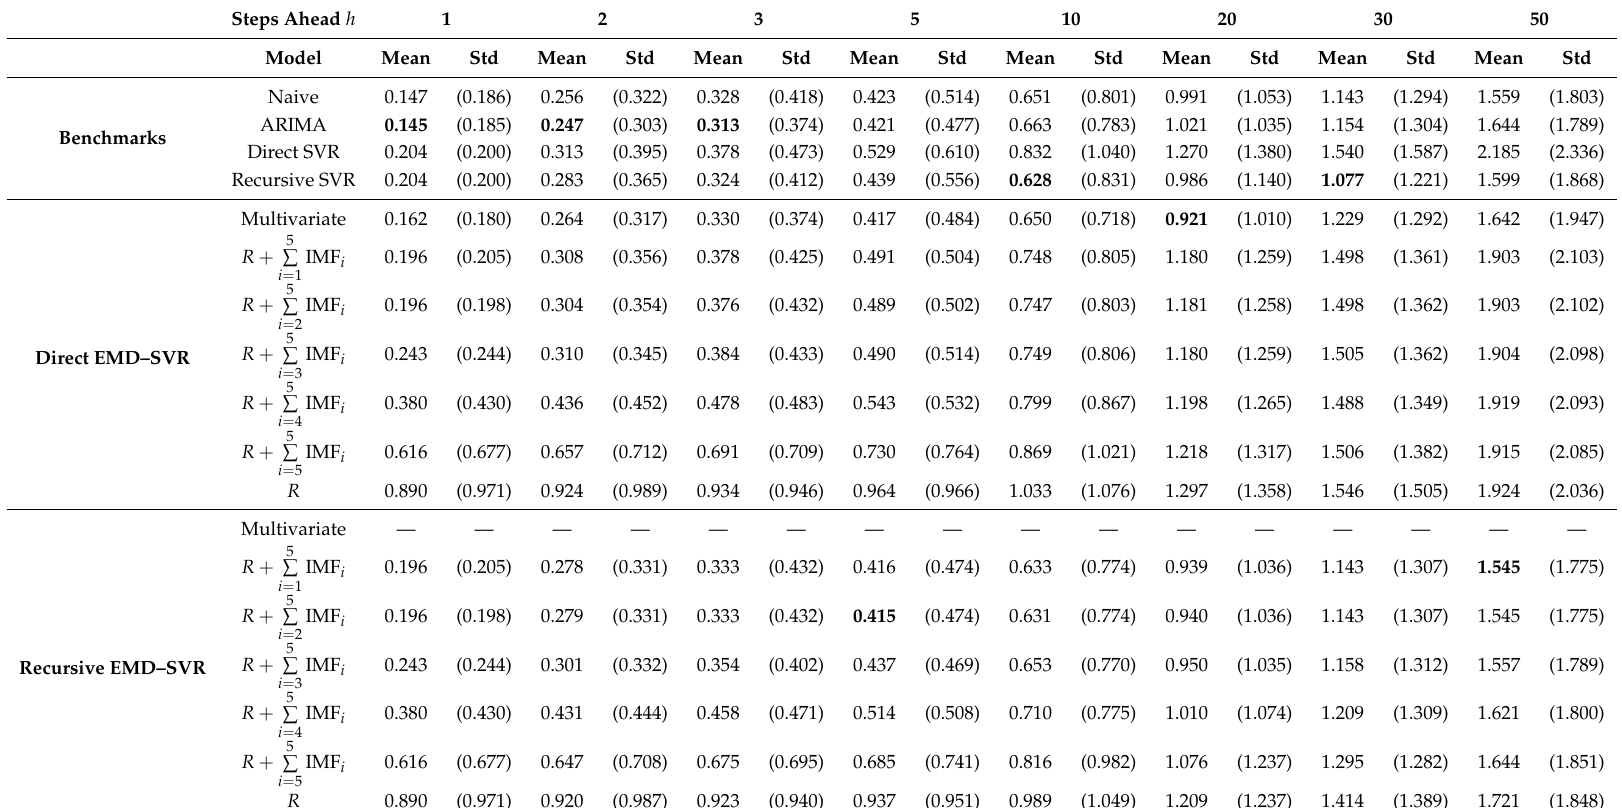
Table A1. Mean absolute error (MAE): mean and standard deviation (std) for the considered forecasting models with input vector m = 1 lagged values. The smallest MAE of each forecast horizon is set in